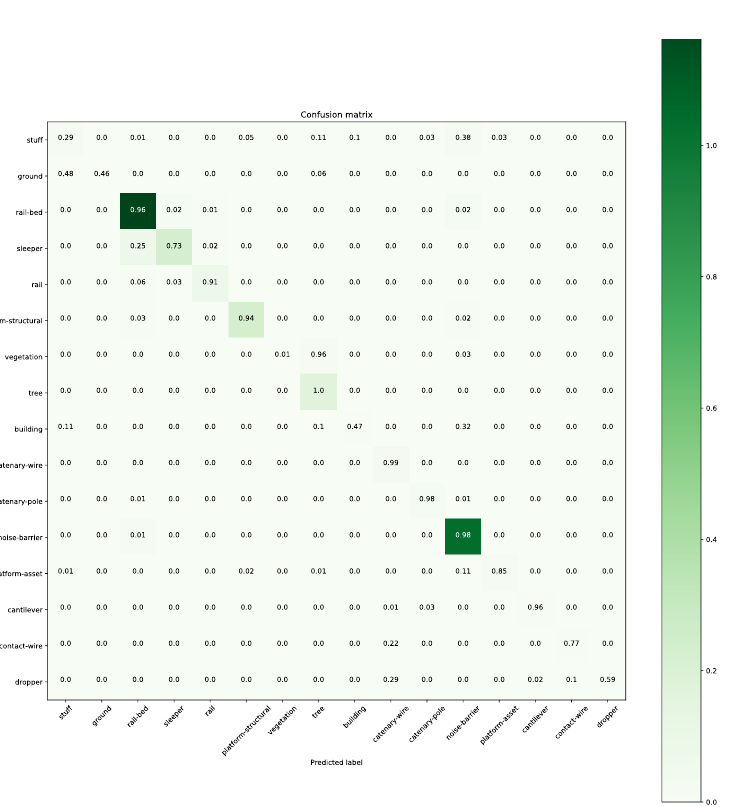
Figure A2. Summary for the 20% validation for step 70. Validation points are picked with means to spatial coverage (KPconv).